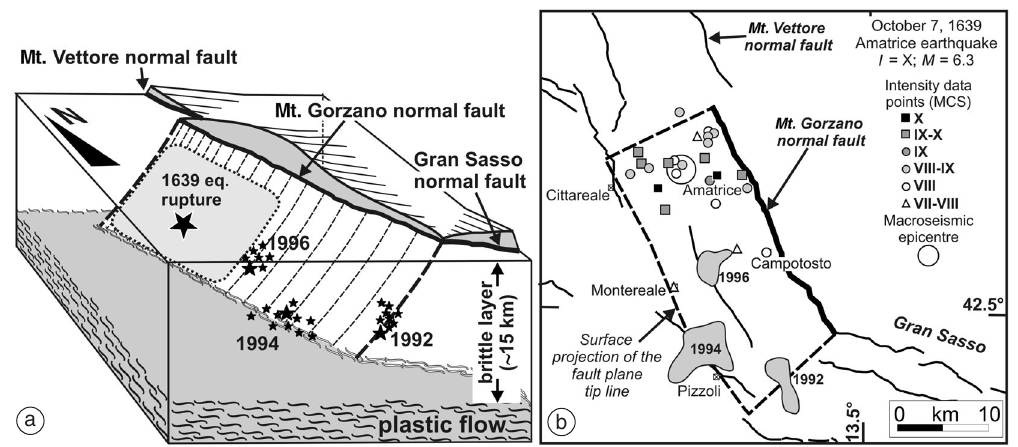
Fig. 10a,b. a) Interpretative block-diagram illustrating the relations between the Mt. Gorzano normal fault and the occurrence of the October 1639 earthquake ( I = X, M = 6.3; Gruppo di Lavoro CPTI, 1999) and the 1992, 1994 and 1996 seismic sequences; b) projection at surface of the tip line of the Mt. Gorzano normal fault, MCS intensity data points of the 1639 earthquake ( I ≥ VII-VIII from DOM 4.1 database; Monachesi and Stucchi, 1997) and areas of occurrence of the 1992, 1994 and 1996